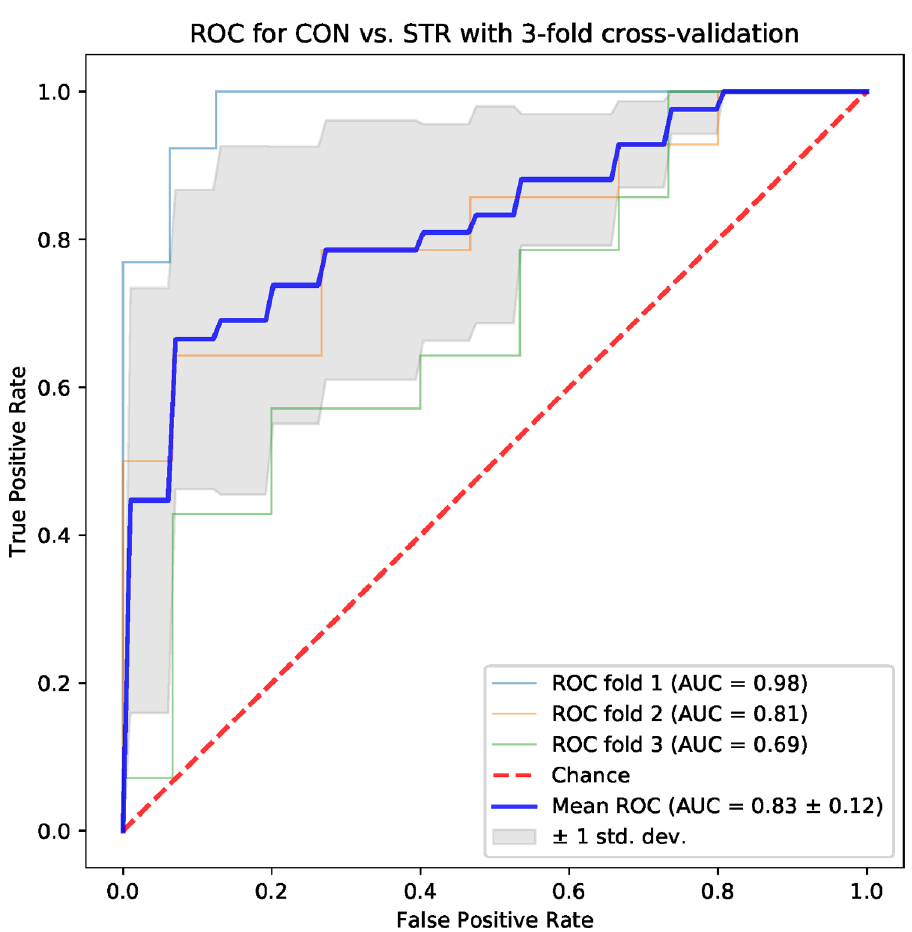
Fig 7. Results for the model trained with four topological parameters: Triangle location, triangle misalignment, number of intervals, frac 5%